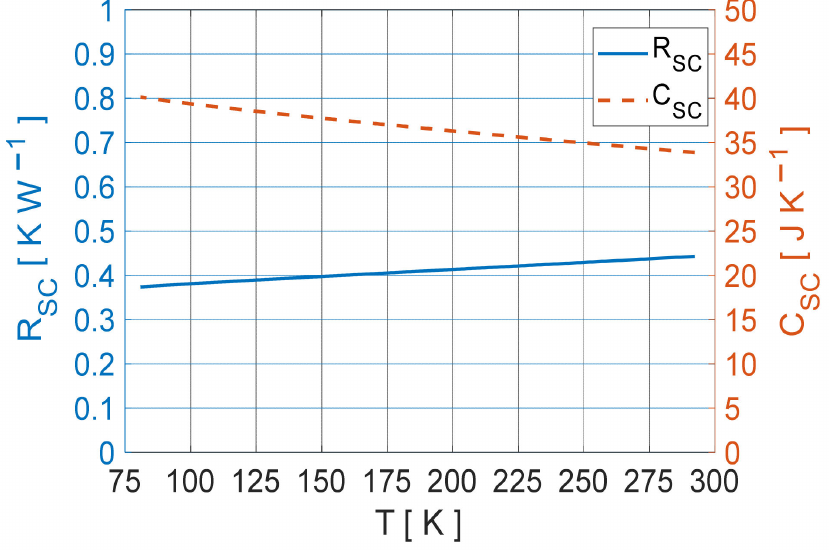
Figure 12. YBCO bulk heat capacity and thermal resistance dependence from internal temperature. Conventional and oscillatory thermal response tests (TRTs) to determine the thermal conductiv- ity and heat capacity of a subsurface were performed [30].